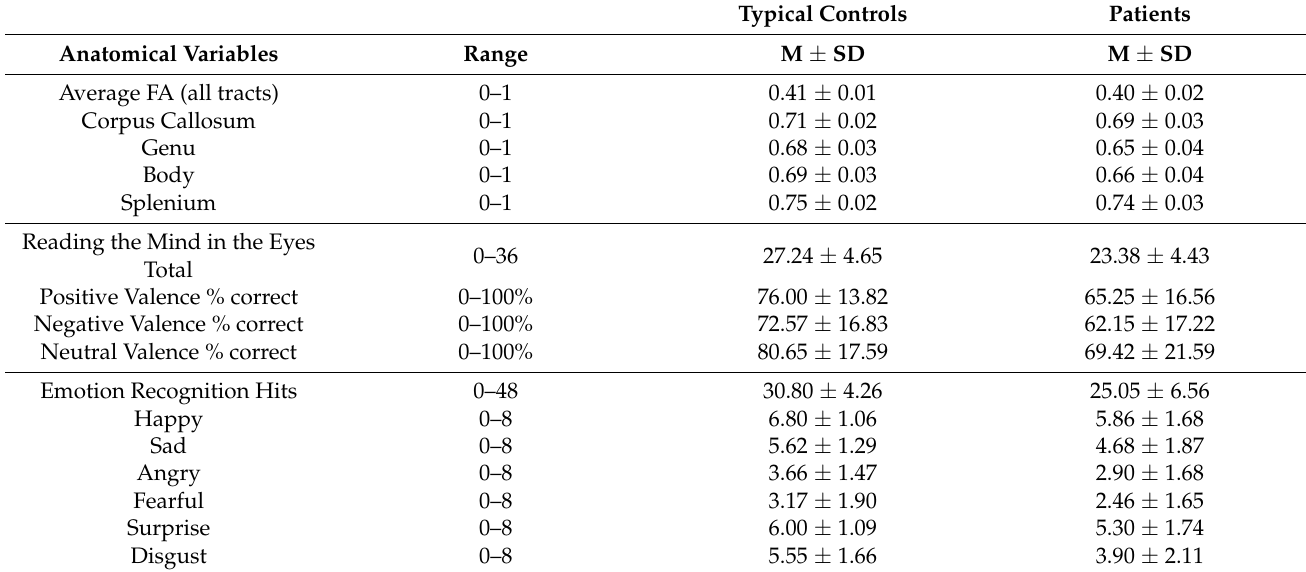
Table 2. Means (M) and standard deviations (SD) for FA white matter regions of interest in schizophre- nia patients (N = 58) and typical controls (N = 178). Typical